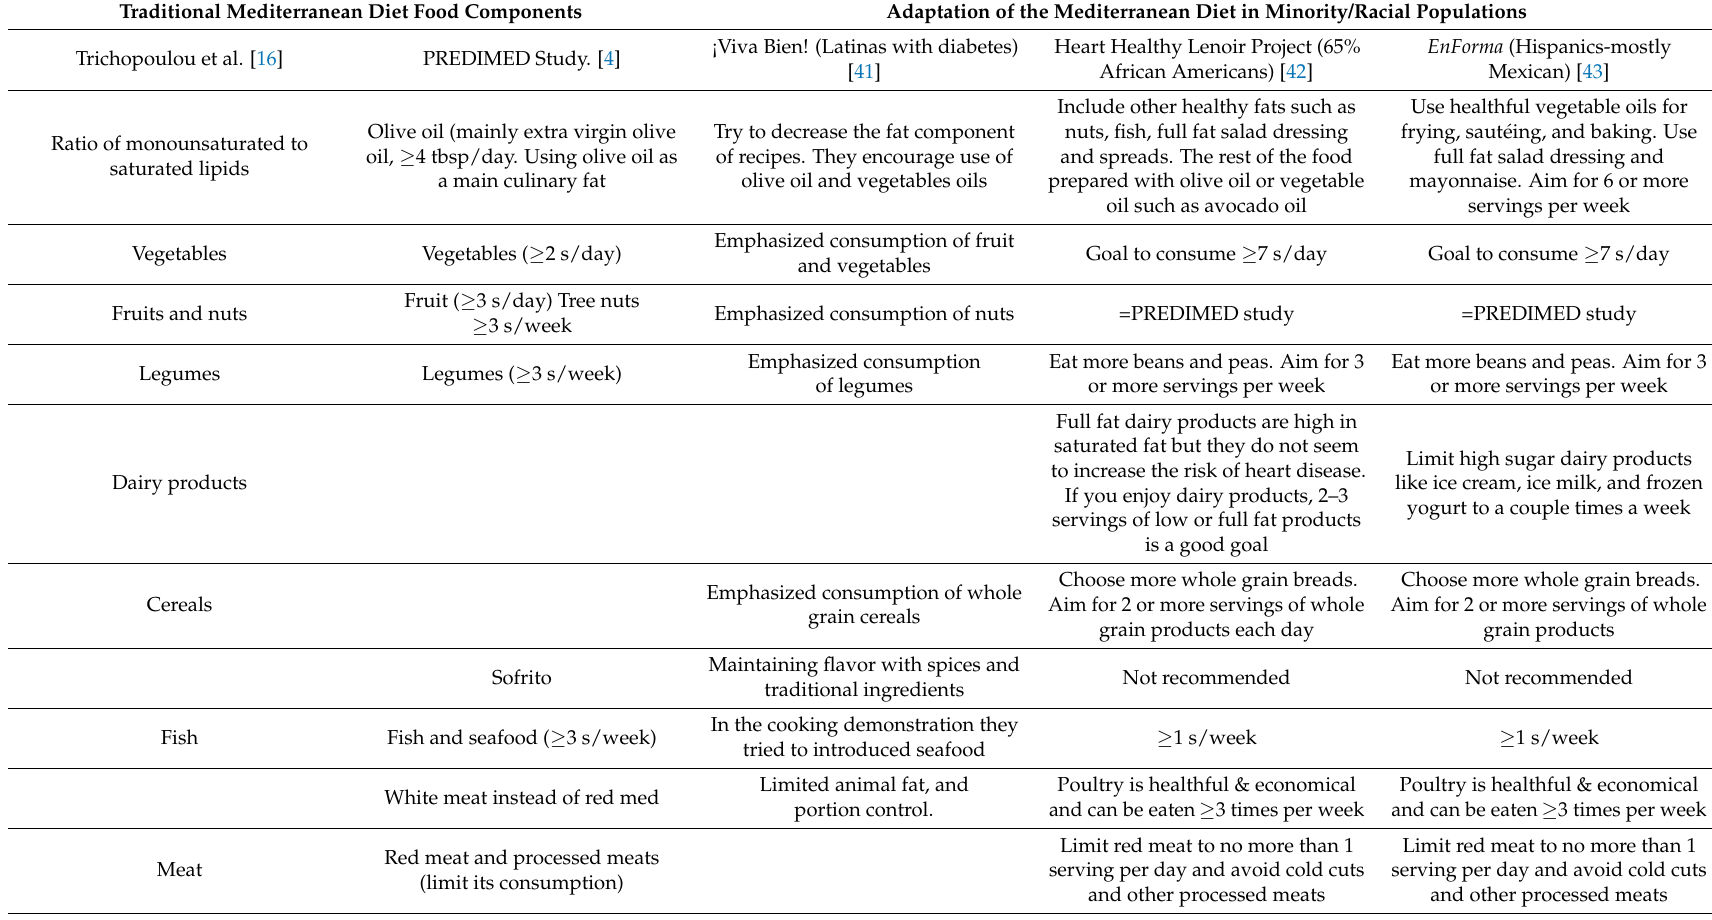
Table 2. Description of the food components recommended by traditional Mediterranean Diet definitions and adaptations from other clinical trials and intervention studies in minority/racial populations in the United